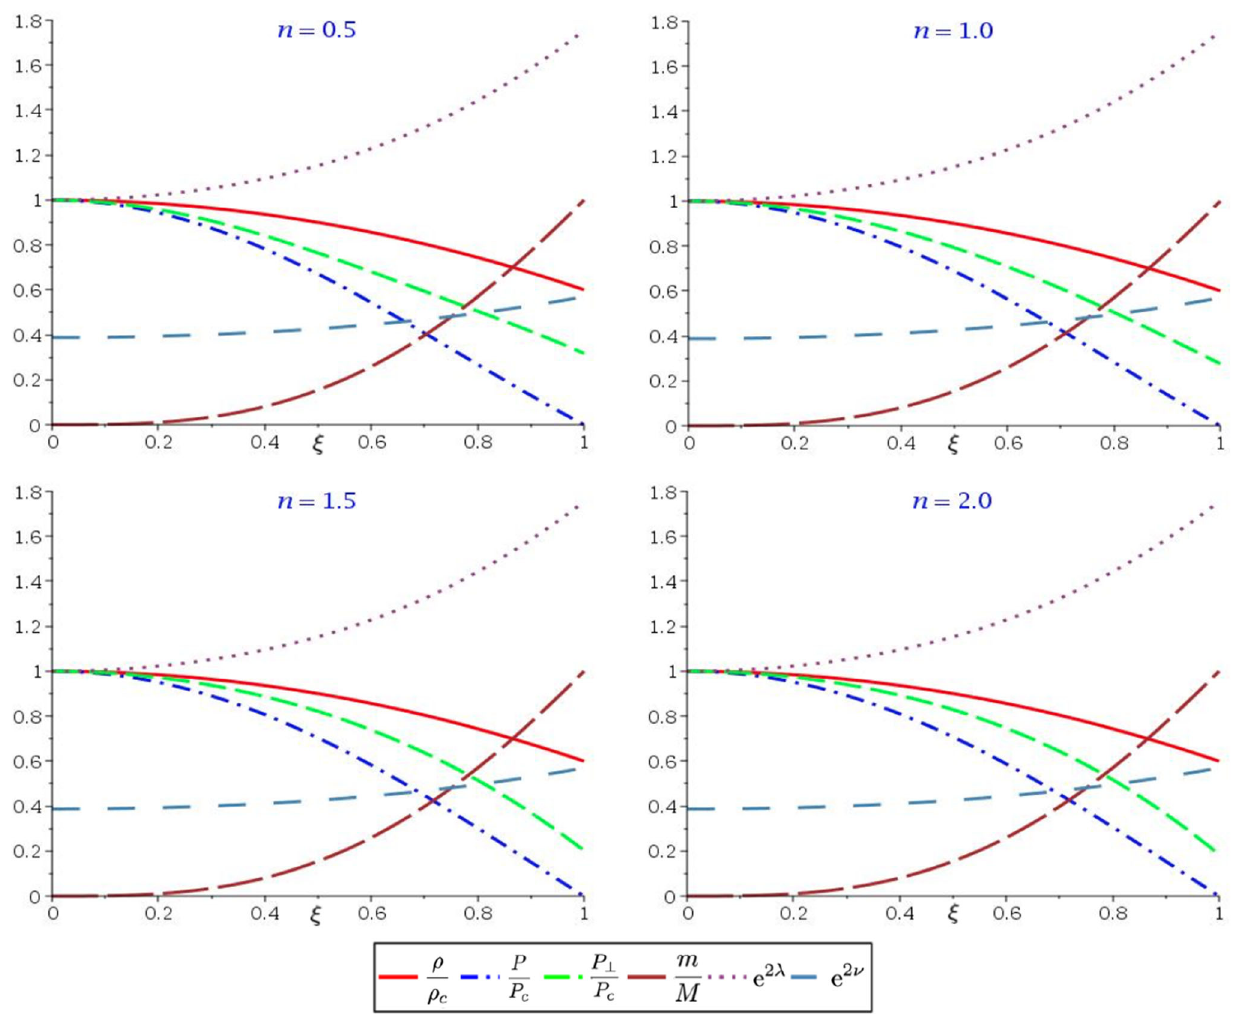
Fig. 1 Physical variables and metric functions for a matter configura- tion with EoS-1. The various plates illustrate different values of n hav- ing σ = 0 . 12. The normalised distributions of density, radial/tangential pressures, mass and components of the metric tensor are given in terms